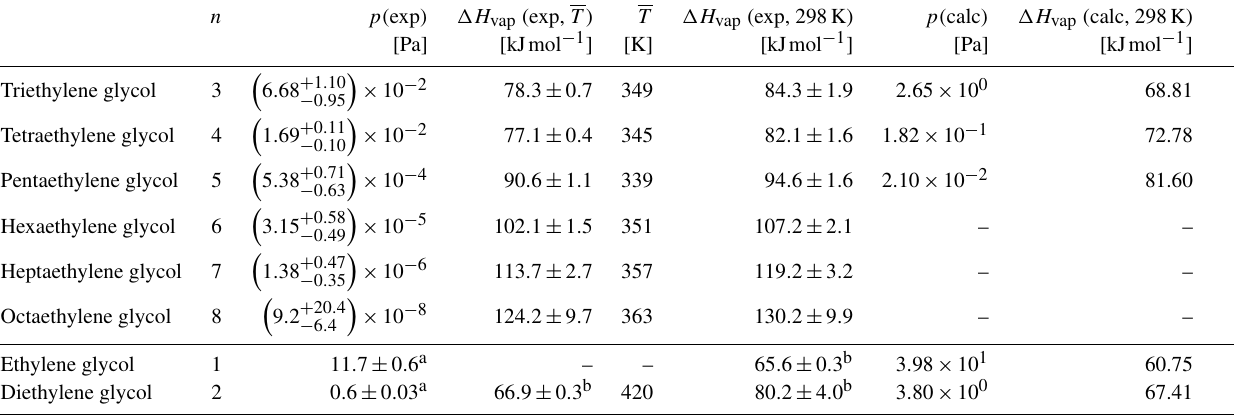
Table 2. Saturation vapor pressures at 298.15K and enthalpies of vaporization of the polyethylene glycols measured in this study as well as estimated enthalpies of vaporization at T (cid:9) = 298 . 15K, together with the results of the quantum chemistry calculations. In addition we provide experimental data from the literature for ethylene glycol and diethylene glycol.